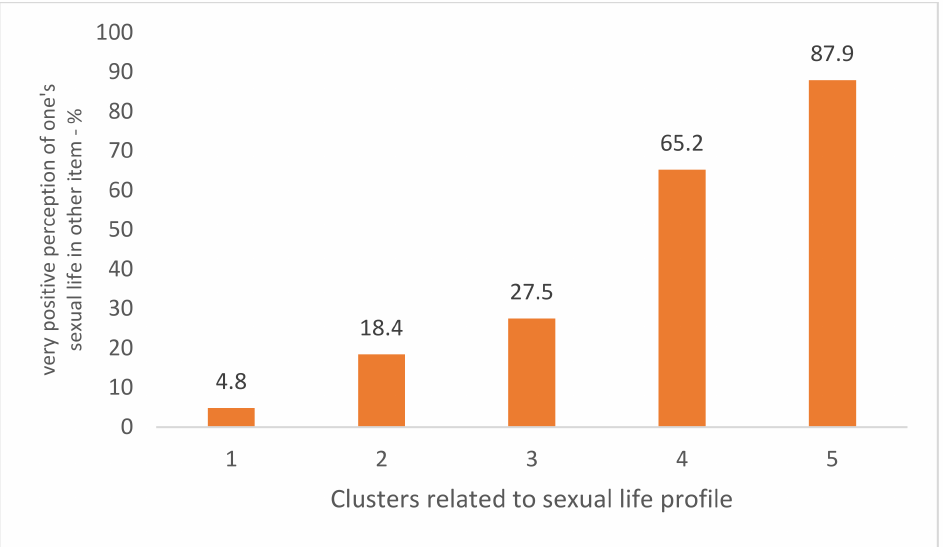
Figure 1. Sexual life assessment profiles suggested by cluster analysis ranked by the percentage of respondents who rated this part of life very well in the independent item (2021